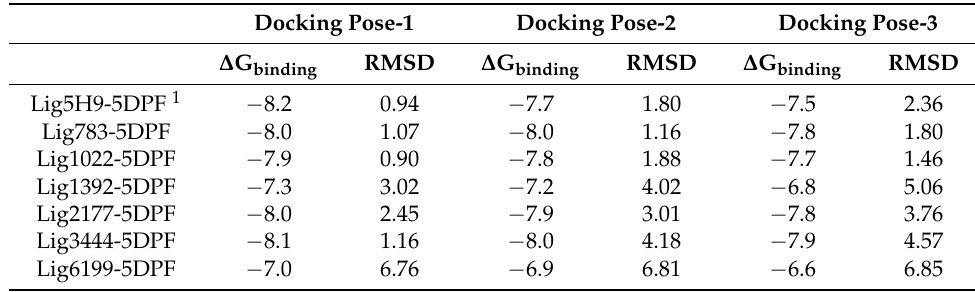
Table 1. Calculated docking ∆ G binding energies (kcal/mol) and root-mean-square deviation (RMSD) (Å) of the firsts ranked Autodock Vina poses of ligand-thermolysin